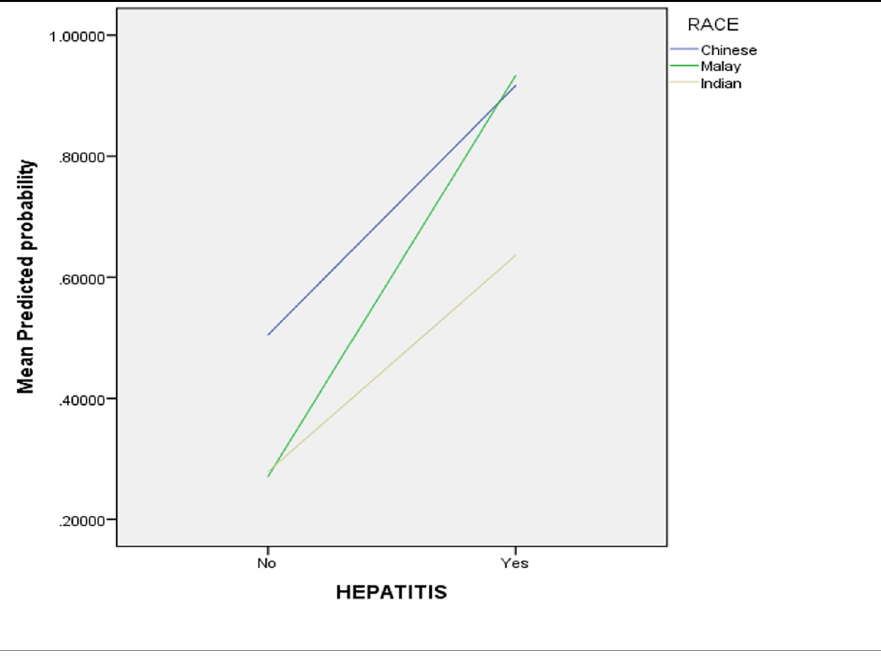
Fig 2. Interaction plot for the predicted probability of HCC by ethnicity and viral hepatitis status. The crossed lines showed the evidence of interaction between these factors. Chinese had a significantly (p < 0.05) highest risk of HCC when there is no viral hepatitis infection. However, with the presence of viral hepatitis, Malay had significantly highest odds of HCC, followed by Chinese ethnicity when compared to the Indian ethnicity (p < 0.05).